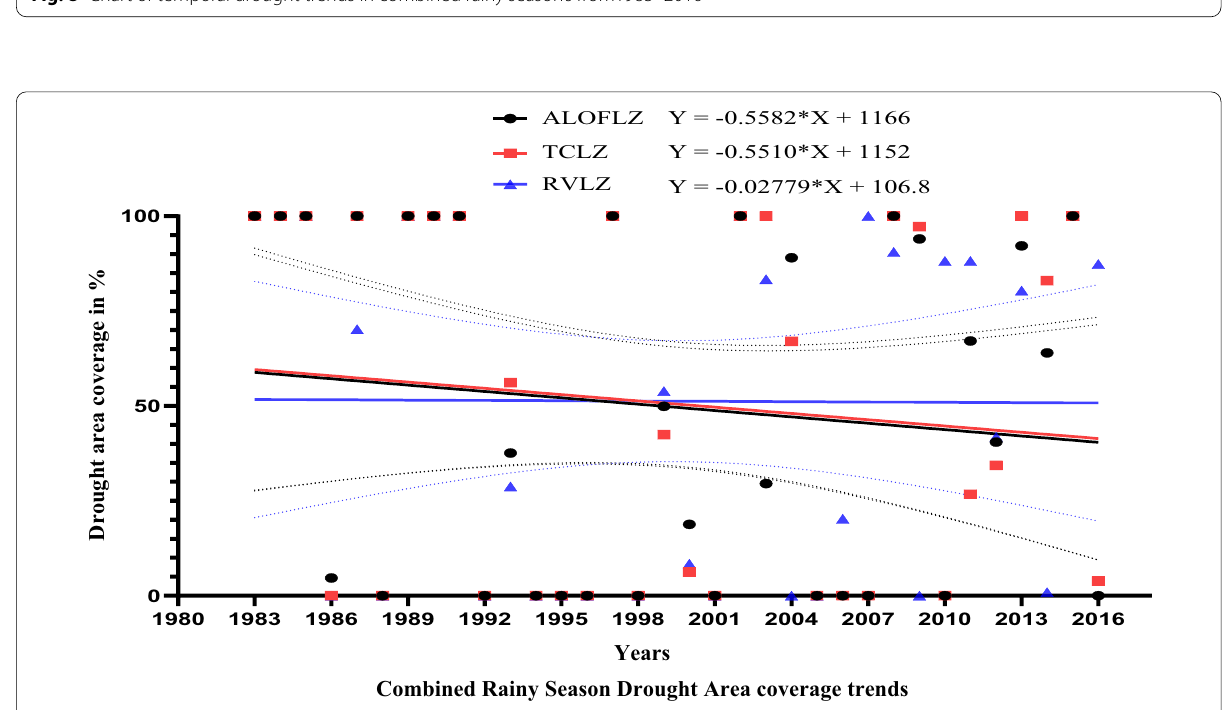
Fig. 9 Spatial drought trends in % of area coverage from 1983–2016 using GraphPad Prism in combined rainy